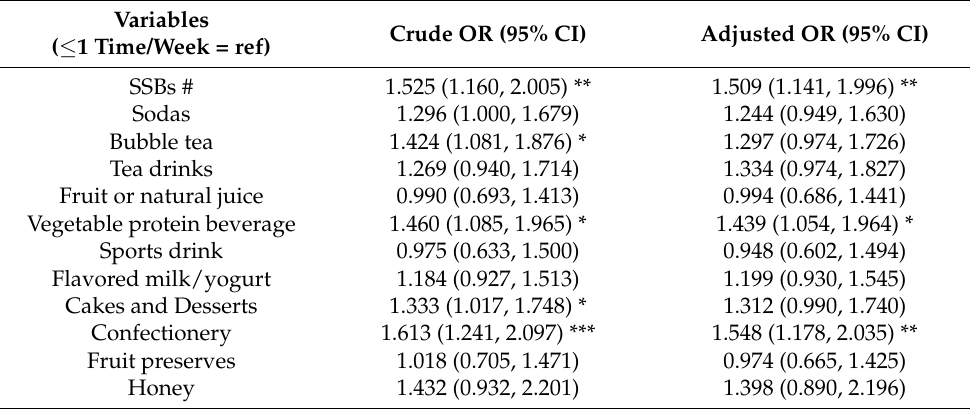
Table A5. Binary logistic regression models on the associations between EDS and consumption frequencies of different free sugars sources (No EDS as the reference, n =